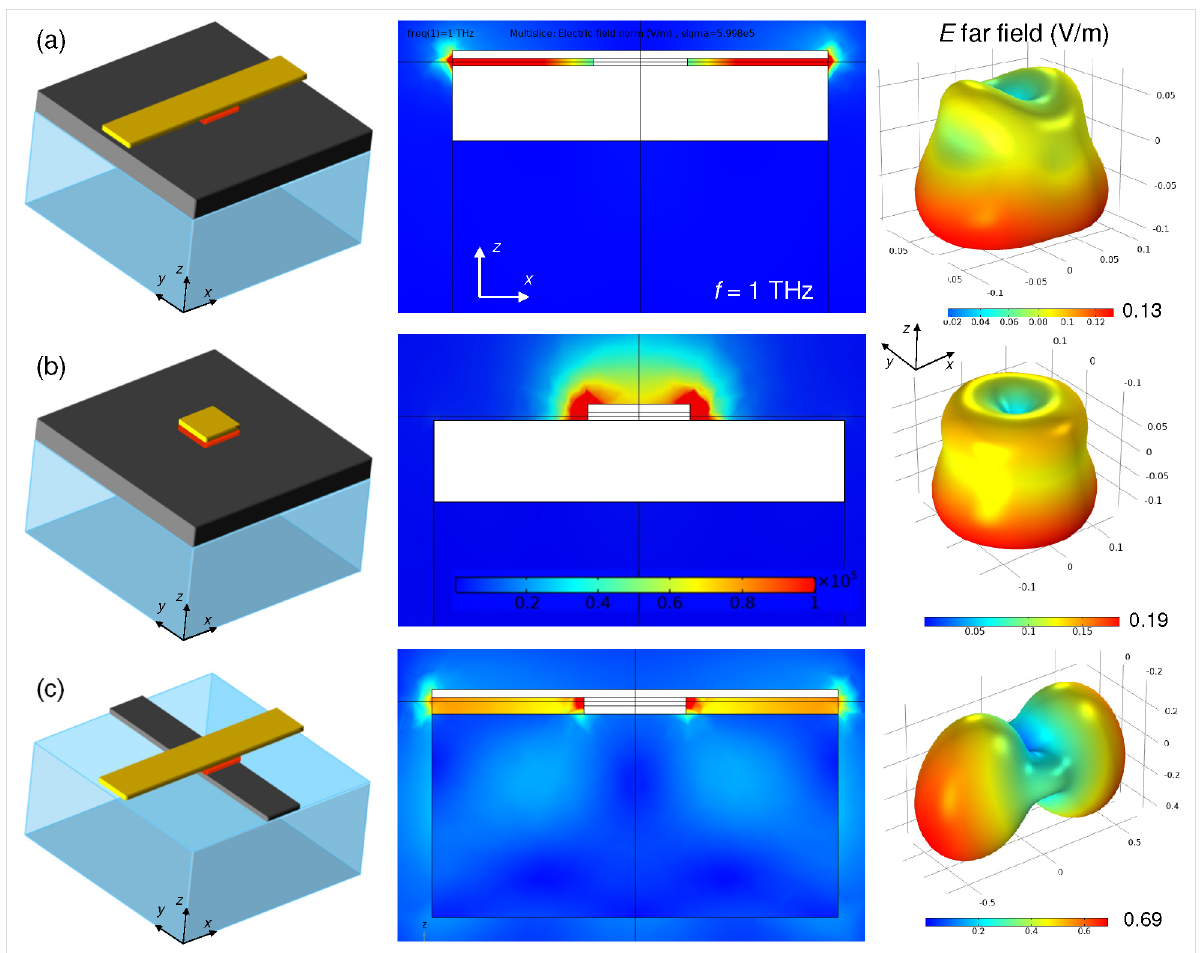
Figure 6: Simulated radiative properties at f = 1 THz for (a) crystal based device, (b) crystal-based device without electrodes, and (c) whisker-based device. Left panels show sketches of devices; middle panels – electric field amplitudes in the x - z cross-section through the mesa; right panels repre- sent radiation patterns for the electric field amplitude in the far-field (outside the simulation sphere). Note a strong field concentration between the crystal and the electrode in (a).